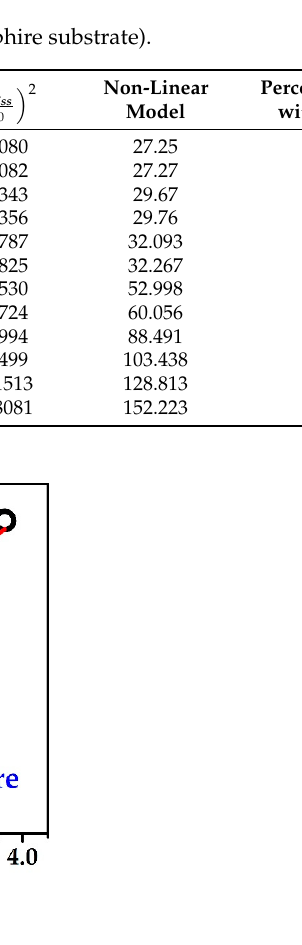
Figure 6. Measurement data (black line and square) and our model (red line and circle). For simplicity, only the sapphire substrate non-linear model is shown here. Table 2. New model and measurement data (sapphire substrate).